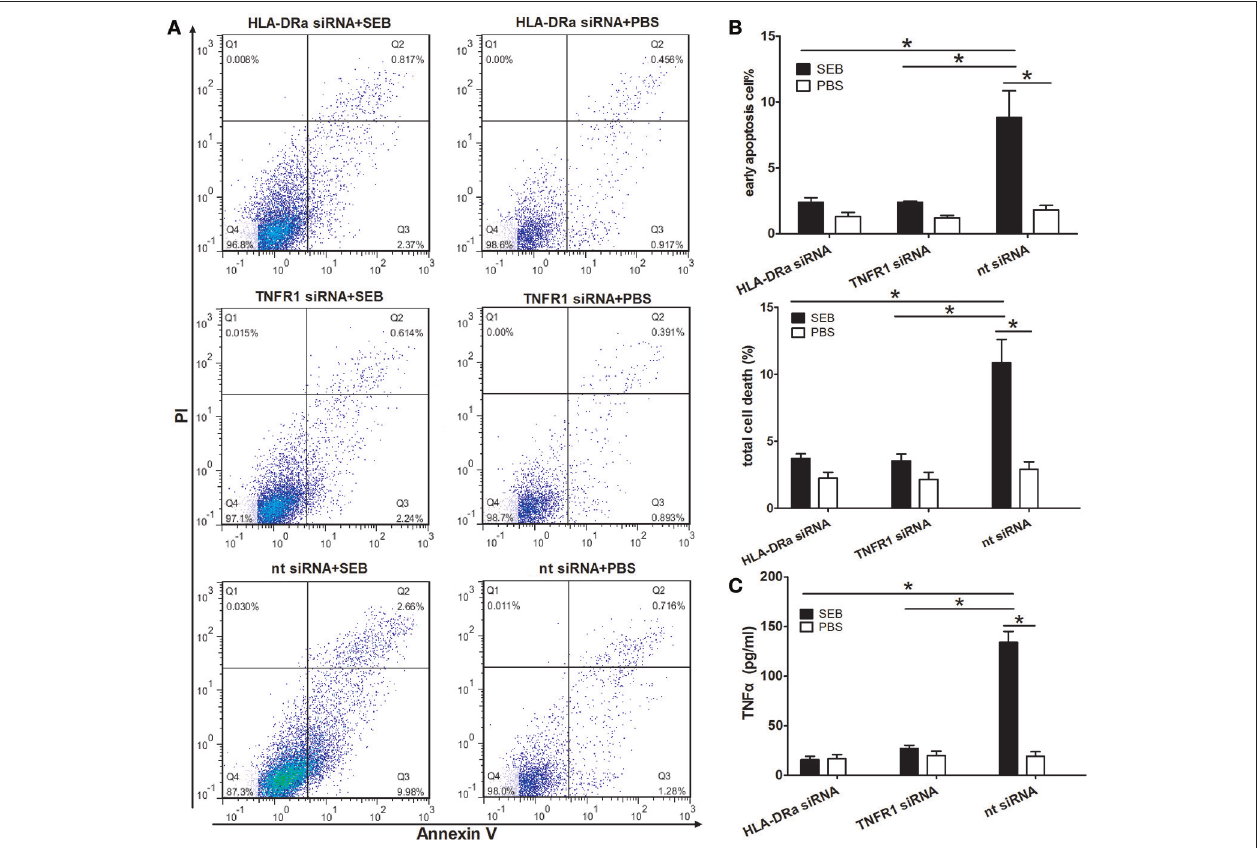
FIGURE 7 | SEB-induced apoptosis and TNF α expression were reduced in HLA-DRa- and TNFR1-knocked down THP-1 cells. The siRNAs inhibition was conducted as described in Materials and Methods. HLA-DRa- and TNFR1-knocked down cells and control cells (2 × 10 5 per well in 24-well-plates) were treated with 20 µ g/ml (24 µ l/well) SEB or 24 µ l/well PBS for 36h. (A) Apoptosis was measured through Annexin V/PI staining and flow cytometry. (B) Quantitatively analyzed data were presented as means ± S.D . ( n = 4), *indicated P < 0.05. (C) The secreted TNF α in the culture supernatants was quantified through ELISA. Data are presented as means ± S.D . ( n = 3), *indicated P <